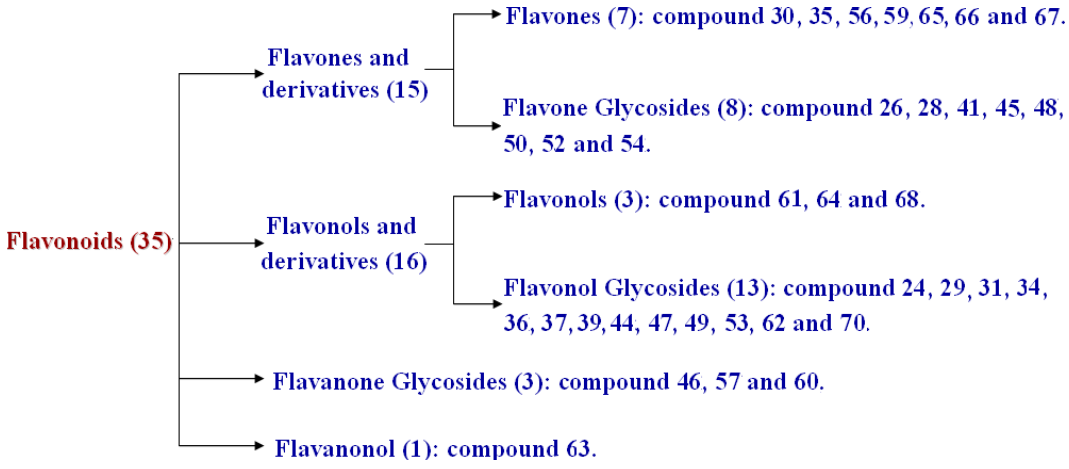
Figure 3. Flavonoids identified in WZYZW by UPLC-ESI-LTQ-Orbitrap-MS.